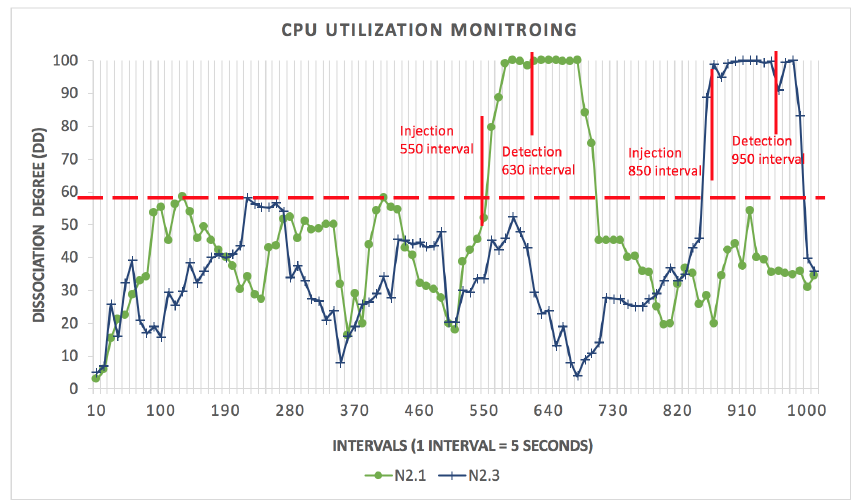
Figure 3. CPU hog detection using HHMM fo the whole system.